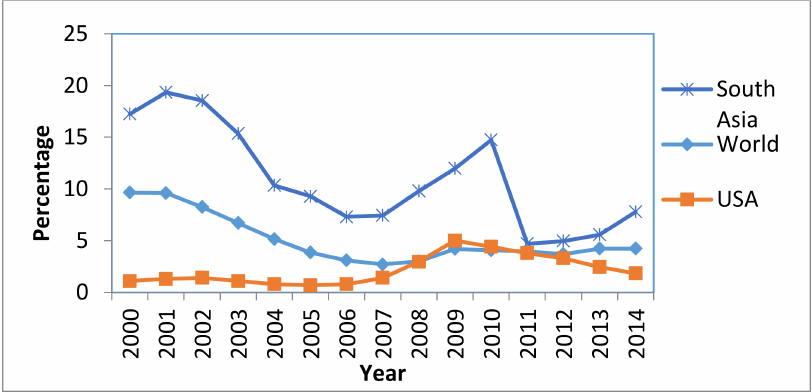
Figure 4. Non-performing loans as a percentage of gross loans (Source: World Development Indicators-World